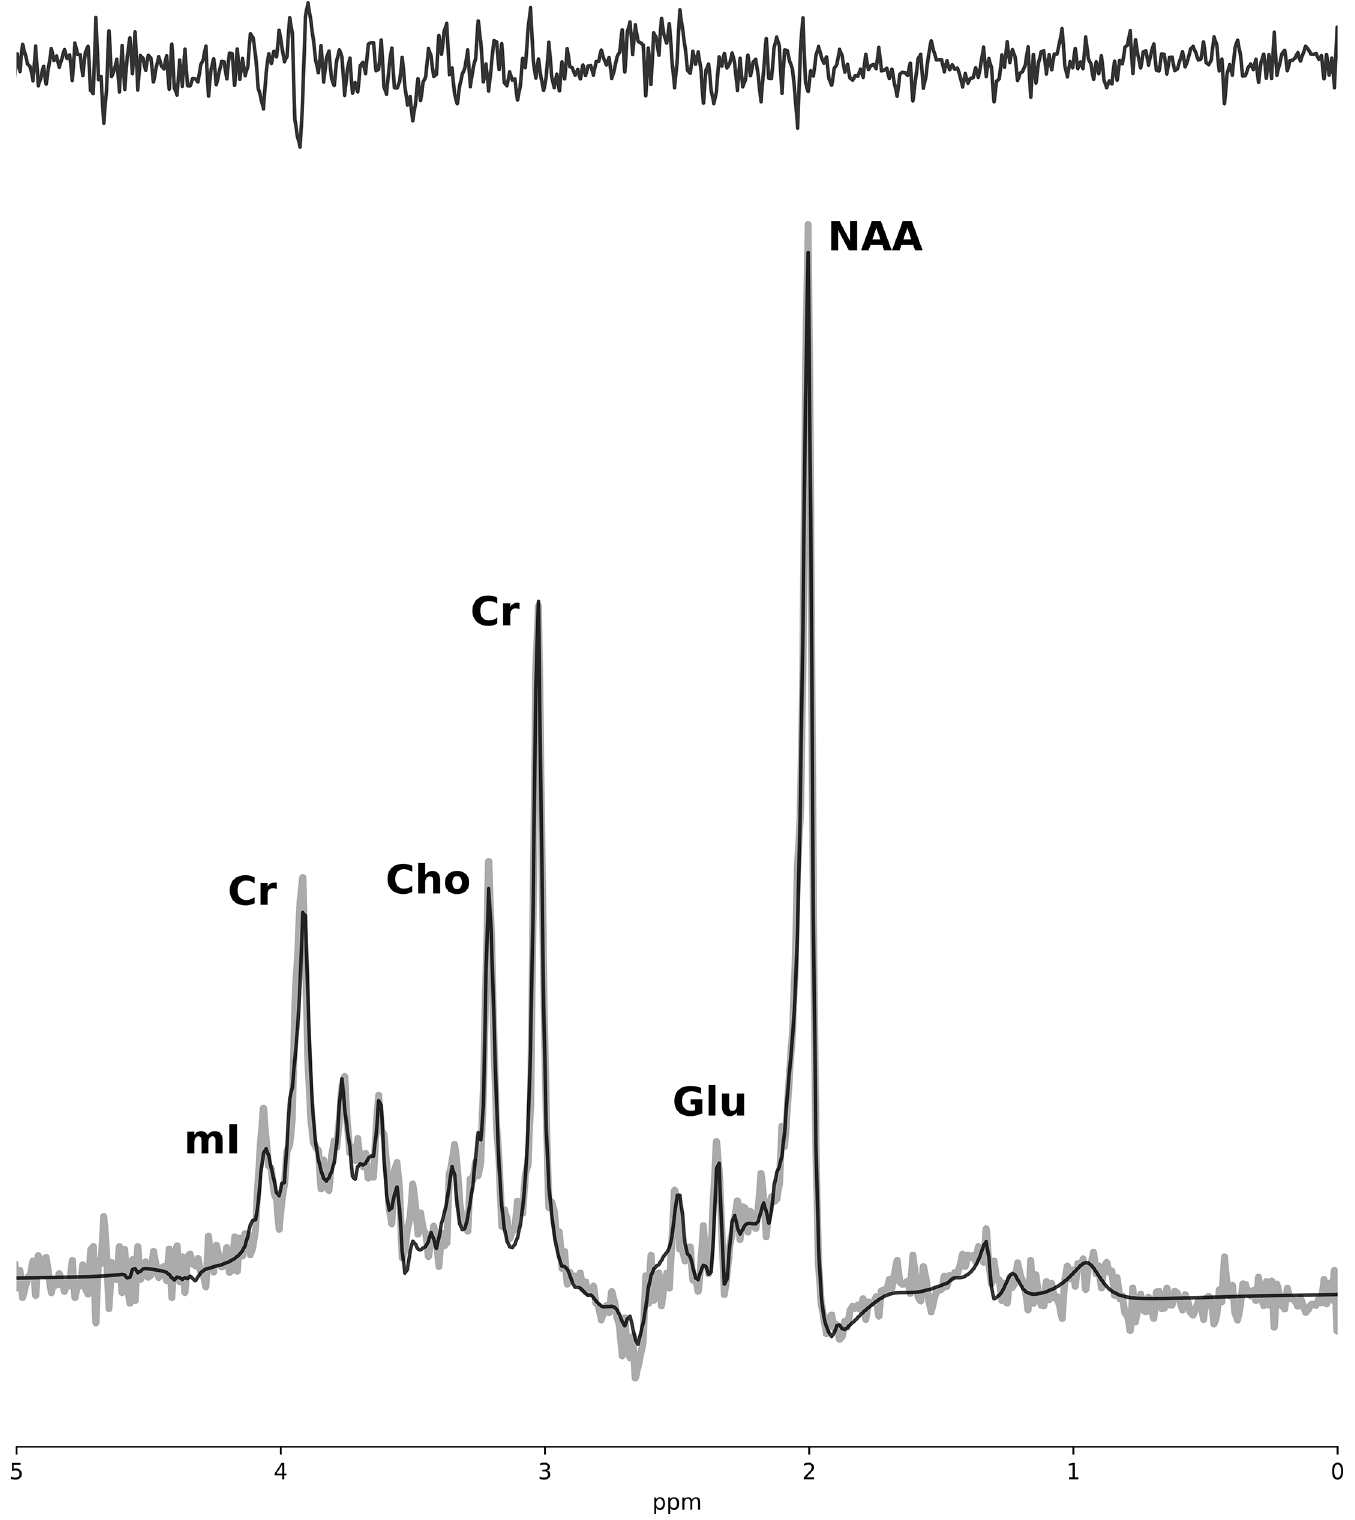
Fig 2. Spectrum of left motor cortex. 7 Tesla semi-LASER 1 H MRS (TE = 60 ms) of the left primary motor cortex. The spectrum (grey) is overlaid on the fitted result (black) with the residual shown above (black). Select metabolite peaks are identified.